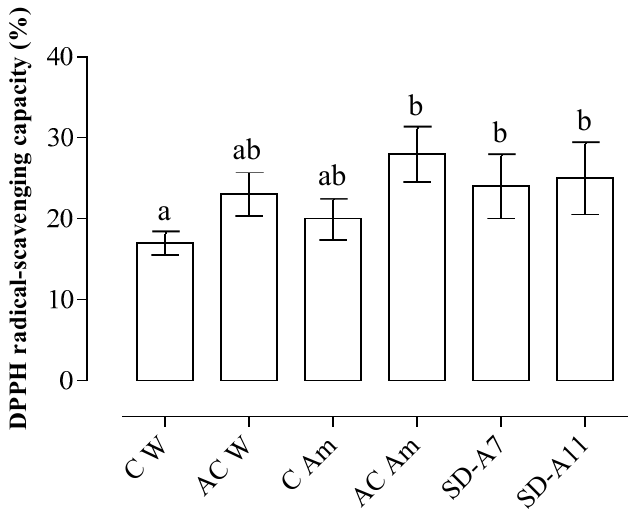
Figure 3. Radical-scavenging capacity (%) of the breads (data are expressed as mean ± coe ffi cient of variation %). C W—wheat control bread; AC W—wheat acid control bread; C Am—amaranth control bread; AC Am—amaranth acid control bread; SD-A7— L. brevis A7 bread; SD-A11— L. farciminis A11 bread. Di ff erent letters ( a , b ) indicate significant di ff erences ( p ≤